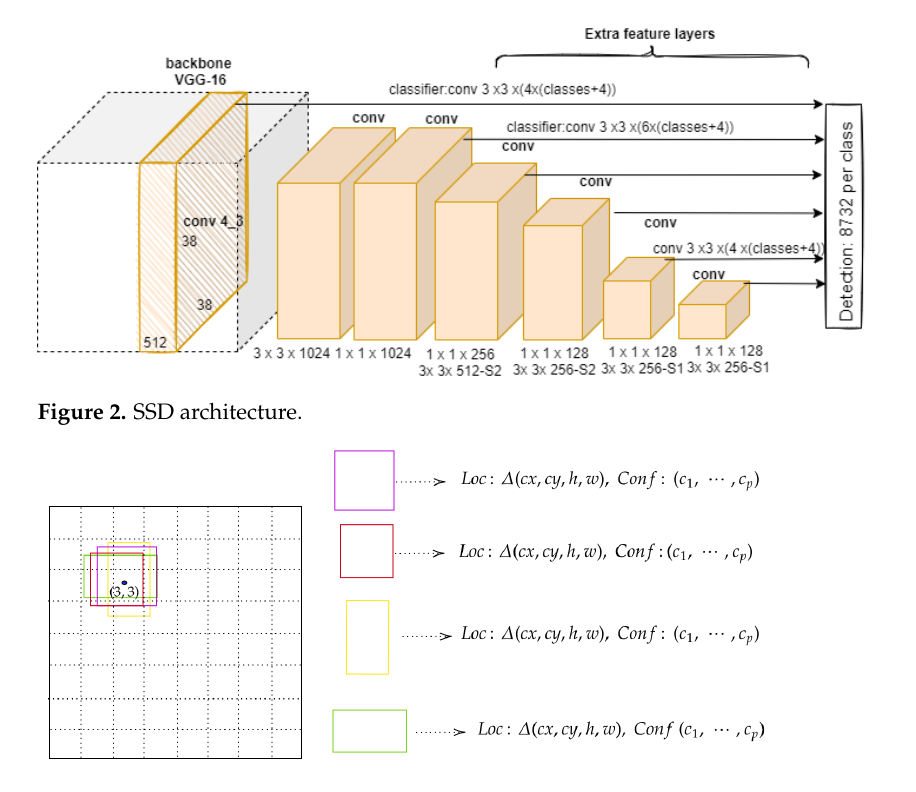
Figure 3. 8 × 8 Feature Map with 4 default boxes at position ( 3,3 ) . For each of the boxes, four offsets and class values are predicted for p